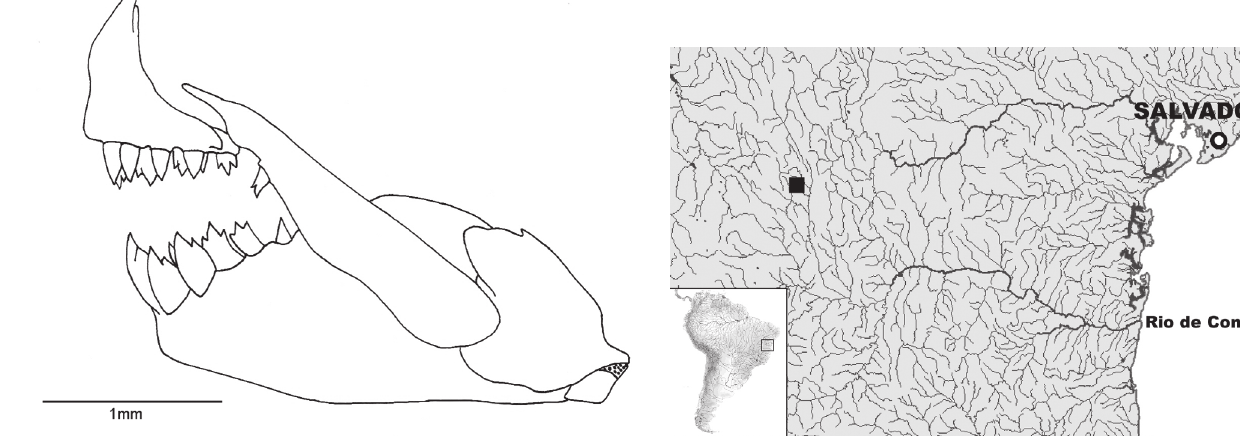
Fig. 3. Hasemania piatan , paratype, DZSJRP 11933, 26.9 mm SL, premaxillary, maxillary and dentary; left side, lateral view.